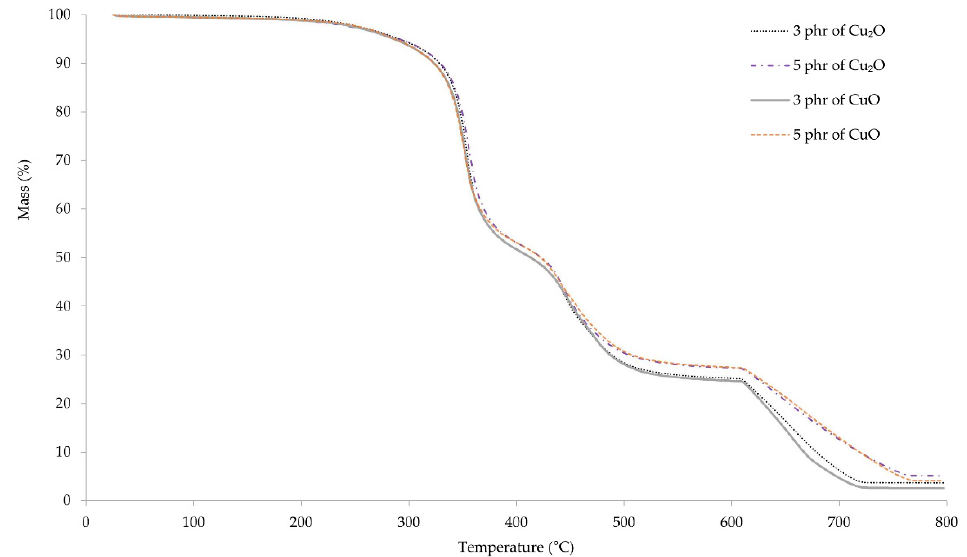
Figure 8. TGA spectrum of CR vulcanizates; T = 160 °C, t = 45 min.